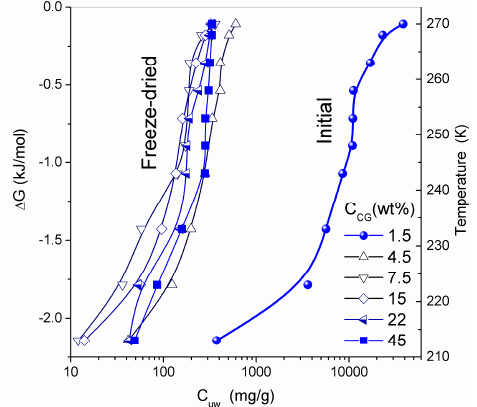
Figure 9. Amount of unfrozen water ( C uw ) as a function of temperature; and changes in the Gibbs free energy of interfacial water versus C uw at different concentrations of collagen in the hydrogel (adapted from [76] with permission, Copyright 2006, Elsevier).